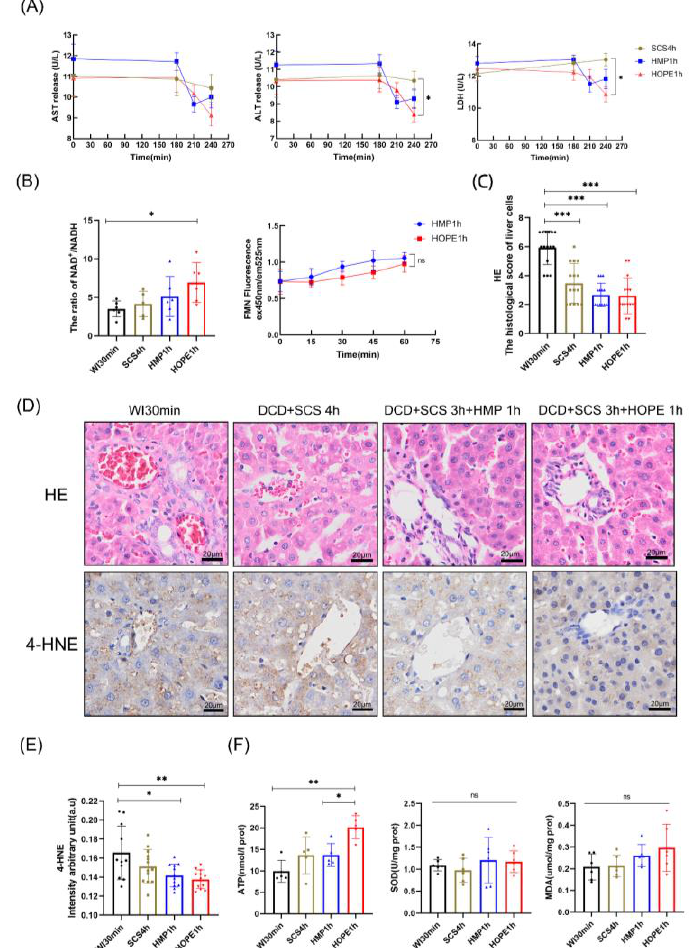
Figure 2. Liver function in the four groups in perfusion series 1. ( A ) ALT, AST, and LDH activity in the perfusate. Data were transformed to a log2 scale. ( B ) The ratio of NAD + /NADH in four groups. During hyperthymic perfusion for 1 h with fluorescence of FMN in perfusate every 15 min, detection of the emitted light was quantified at 525 nm, while excitation was performed at a wavelength of 450 nm. ( C ) Histological scores were analyzed based on Suzuki’s criteria. ( D ) H&E staining was performed on the paraffin- embedded sections of rat liver tissues. Scale bar: 20 μm; IHC staining of 4-HNE was performed on the paraffin- embedded section of rat liver tissues. Scale bar: 20 μm. ( E ) IHC stained 4-HNE were quantified using Image J. ( F ) ATP, SOD, and MDA were tested to evaluate mitochondrial function. ( n = 6 per group for ( A , B , F) ; for ( C , D) , n = 3 independent experiments). Mean ± SD, N.S., p > 0.05, * p < 0.05, ** p < 0.01, *** p < 0.001.